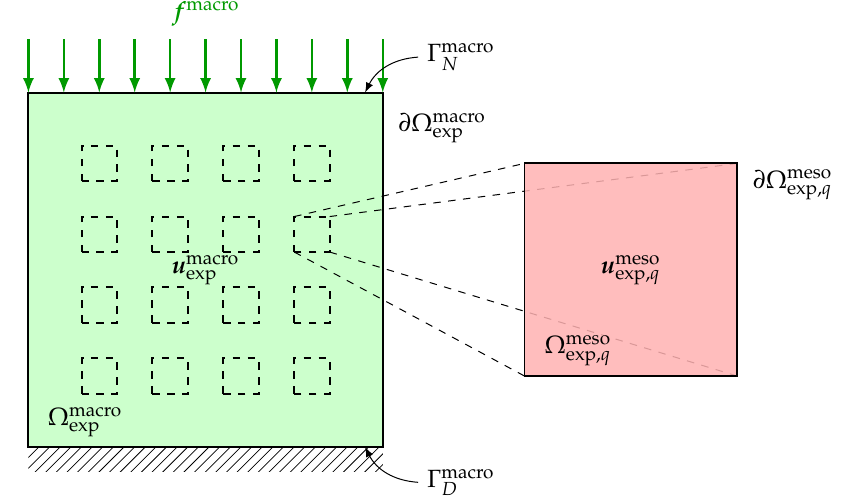
Figure 1. Multiscale experimental configuration: displacement field u macro exp measured in the macroscopic domain of observation Ω macro exp and displacement field u meso exp, q measured in each mesoscopic domain of observation Ω meso exp, q , for q = 1, . . . , Q